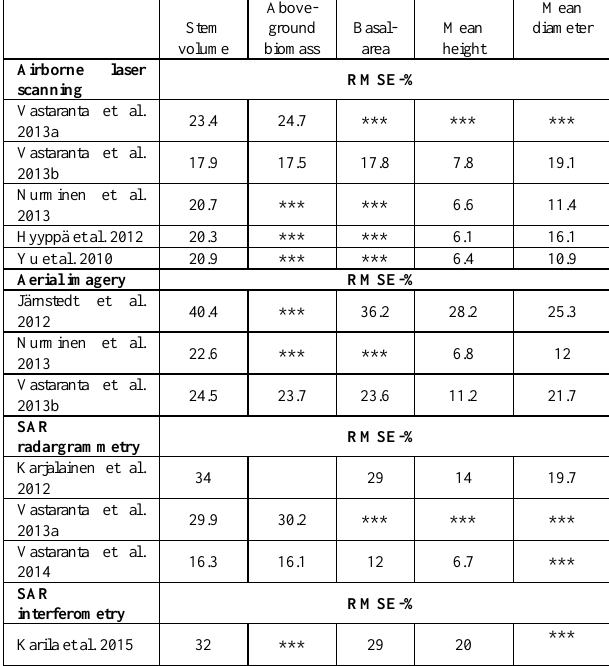
Table 2. Obtained accuracies in forest attribute